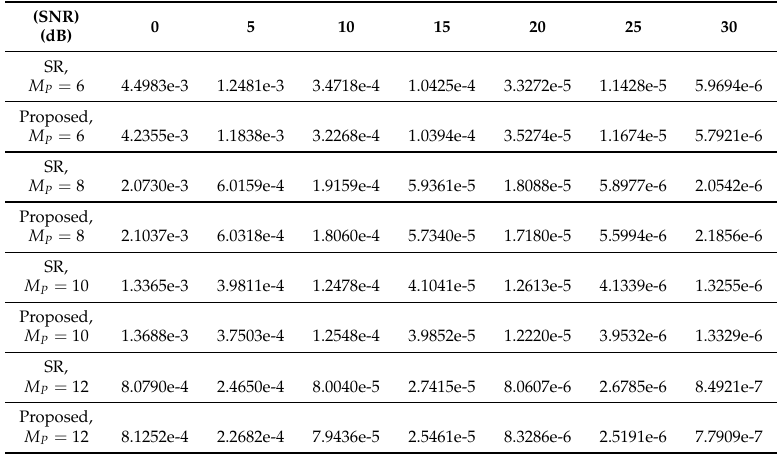
Table 1. NMSE of the proposed scheme and SR algorithms in different time slots.